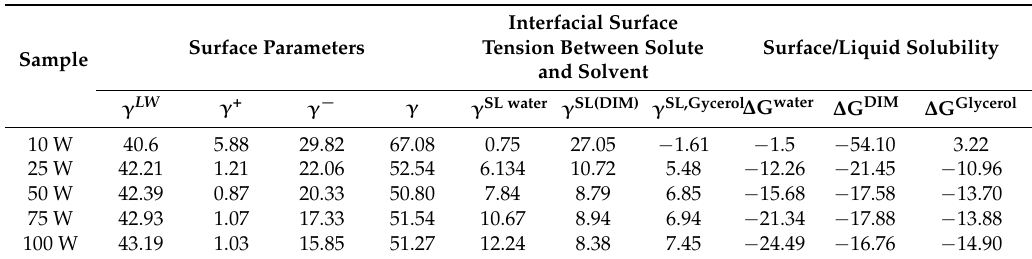
Table 6. Surface tension parameters and corresponding solubility for geranium oil-derived thin polymer films deposited at varied RF